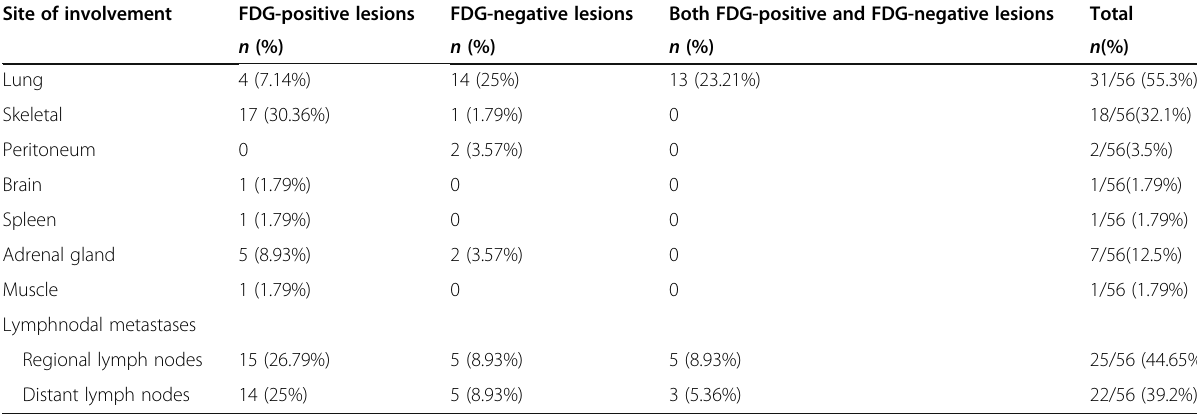
Table 4 Distribution of overall extrahepatic metastases of HCC on FDG PET CT in 56